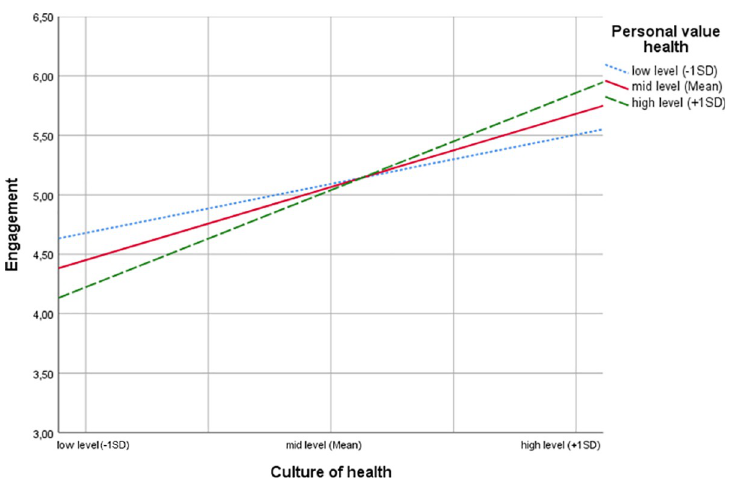
Fig 5. Interaction plot for employee